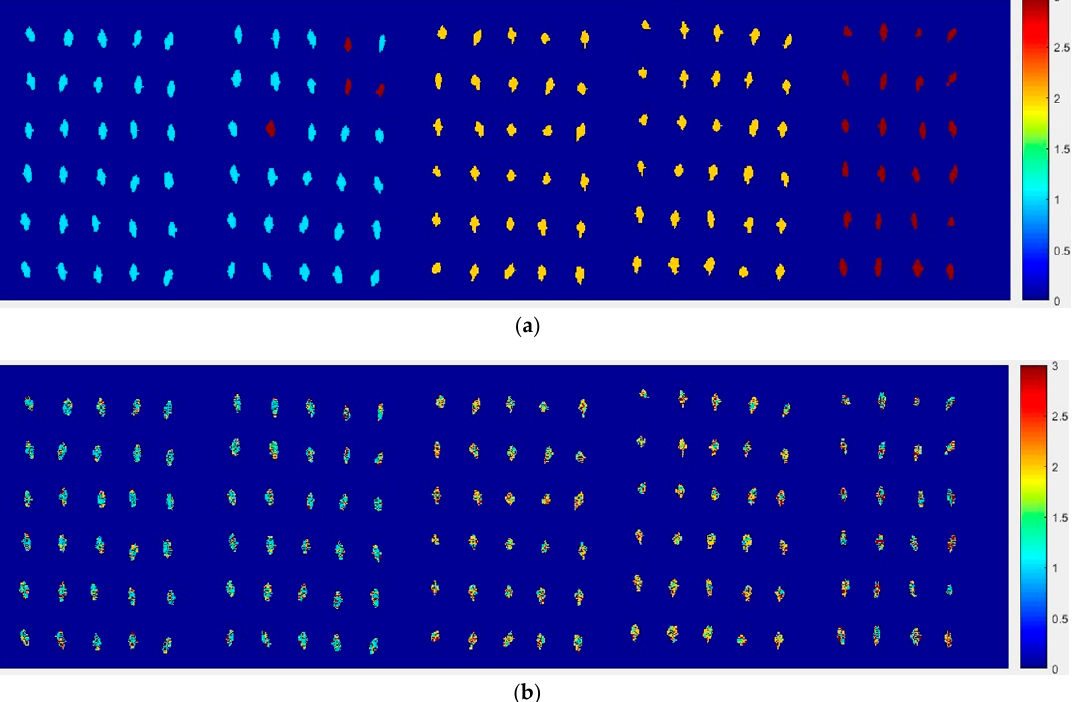
Figure 13. The visualization images (a) method M2M and (b) method M2P for Jindan10 with the SPA and PLS-DA model.